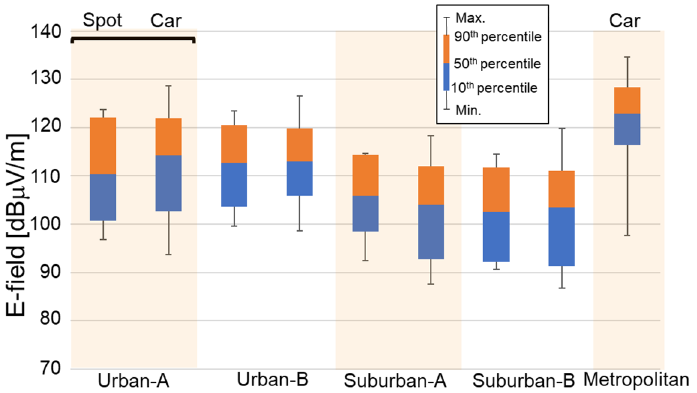
Figure 6. Box plot of E-field strength measured by car and those of past spot measurement for mobile phone systems.